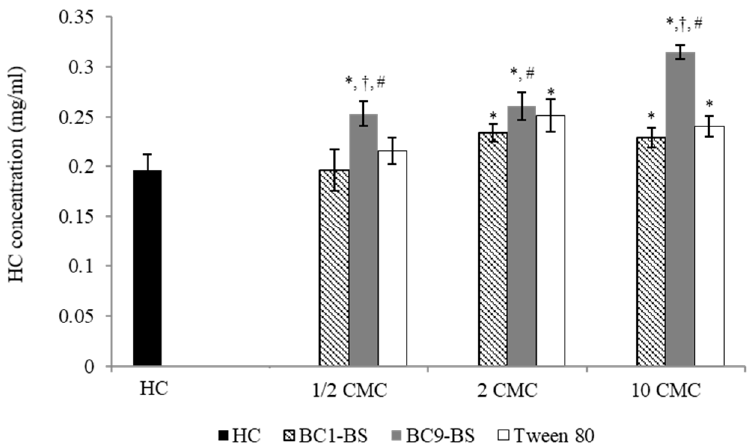
Figure 2. Solubility of HC at 25 °C as a function of surfactant concentration below (1/2-fold lower that their CMC) and above (2-fold and 10-fold higher than their CMC) the CMC. Data are expressed as means ± SD, n = 3. Significance indicated by * = p < 0.05 compared to HC solubility without surfactants, by # = p < 0.05 compared to HC solubility in the presence of same concentration of BC1-BS, and by † = p < 0.05 compared to the HC solubility in the presence of the same concentration of Tween 80.